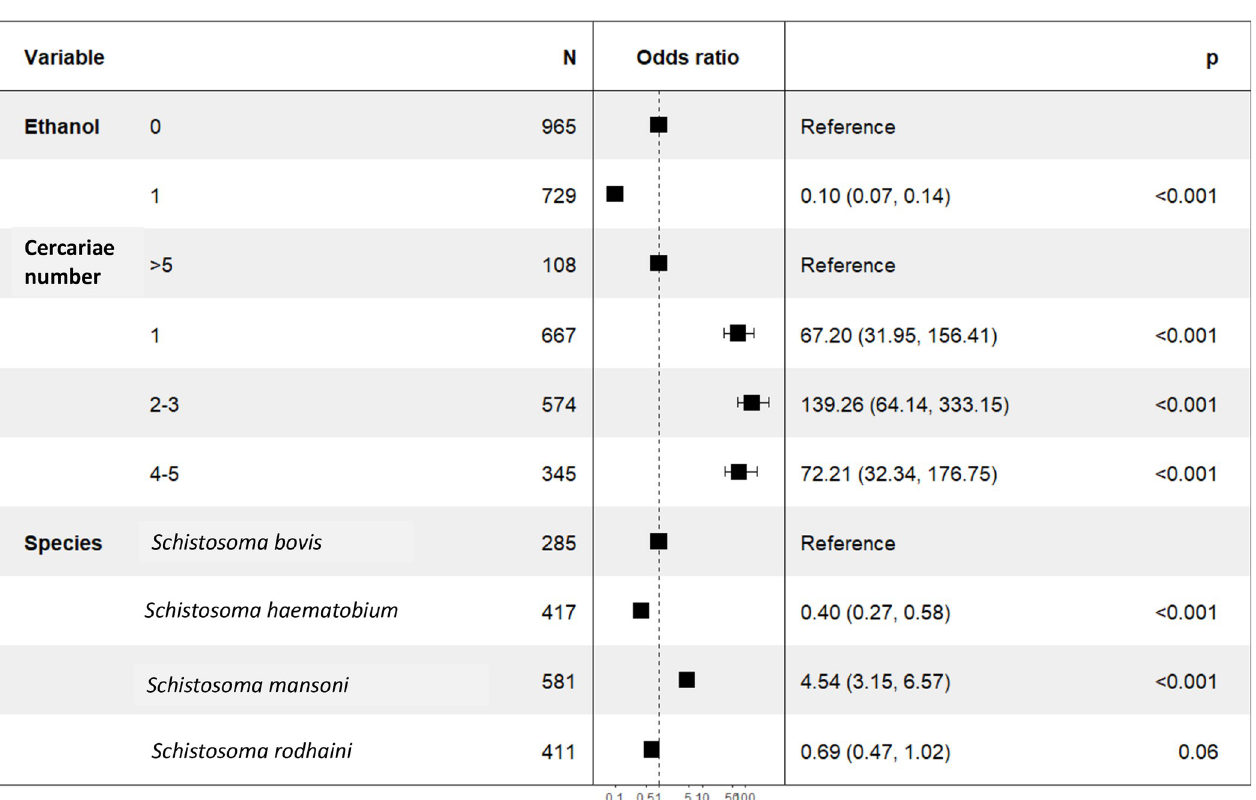
Fig 6. Multivariate analysis of factors influencing spectral identification. Forest plot of significant variables used in logistic regression model for prediction of LSV1 > 1.7.